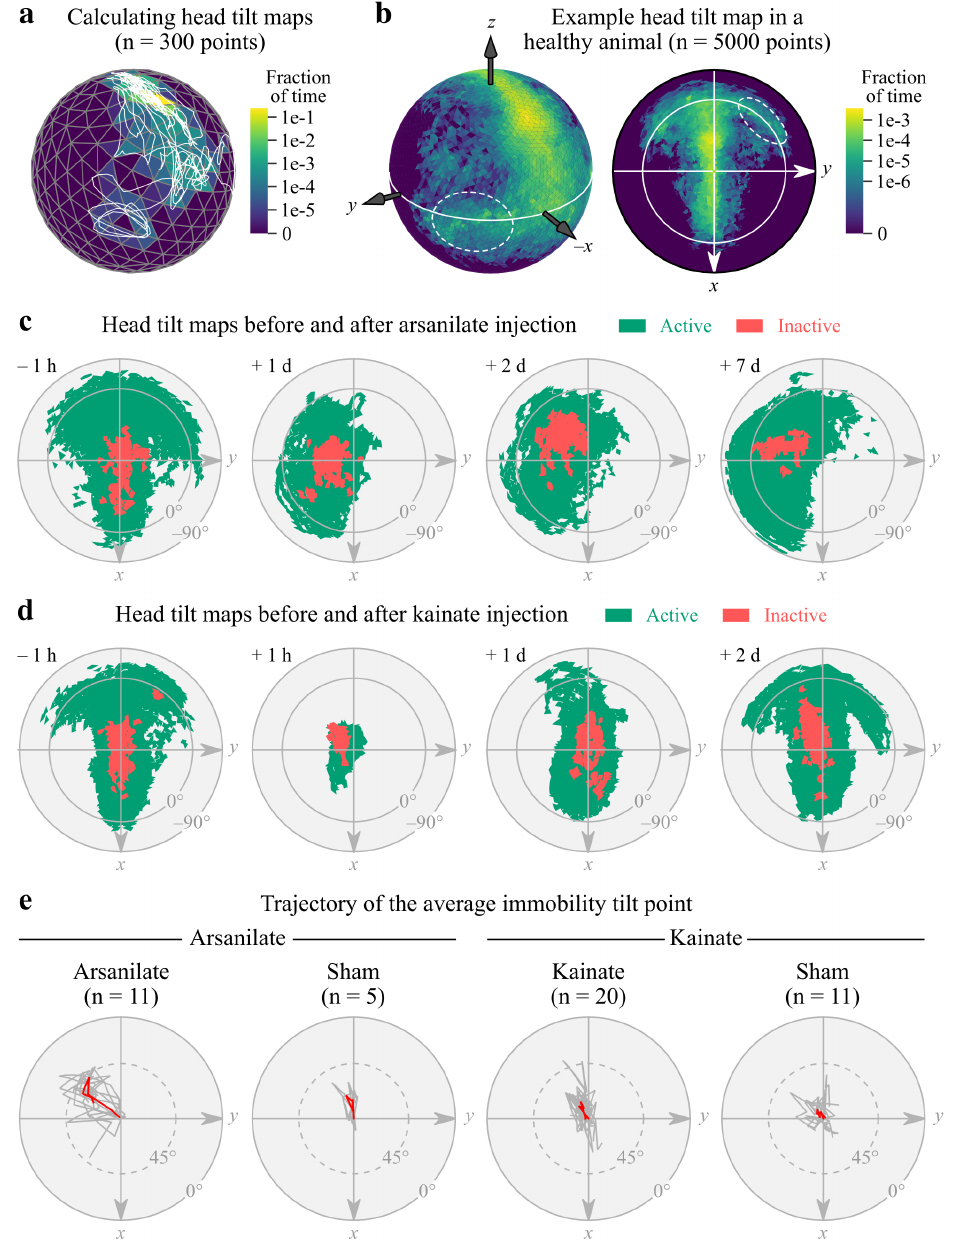
Figure 3. Changes in static and dynamic head tilt following a unilateral vestibular lesion. ( a ) Illustration of the method used to compute head tilt maps: a 45 s trajectory of the gravitational acceleration vector (white line) was plotted in the IMU reference frame on a triangulated unit sphere, with colors reflecting the fraction of time during which the vector passed through each triangle. ( b ) Representative spherical head tilt map of a healthy rat (left) and its 2D projection (right). The white line represents the equator. The dashed white ellipse highlights a region specifically associated with body grooming. ( c , d ) Representative binarized 2D head tilt maps before and after a trans-tympanic injection of arsanilate ( c ) or kainate ( d ), computed for active (green) and inactive (red) periods (data from one animal in each case). Note the complete recovery of a normal head tilt map in kainate-treated animals. Injections were performed in the left ear ( y axis on the maps). ( e ) Trajectories of the average head tilt point during immobility (red curves) for all available time points for arsanilate- and kainate-injected animals and their respective control groups (sham). Individual (per-animal) trajectories and across-animal average trajectories are shown in gray and red, respectively. Individual trajectories were rotated to align the baseline head tilt point (i.e., before injection) with the North